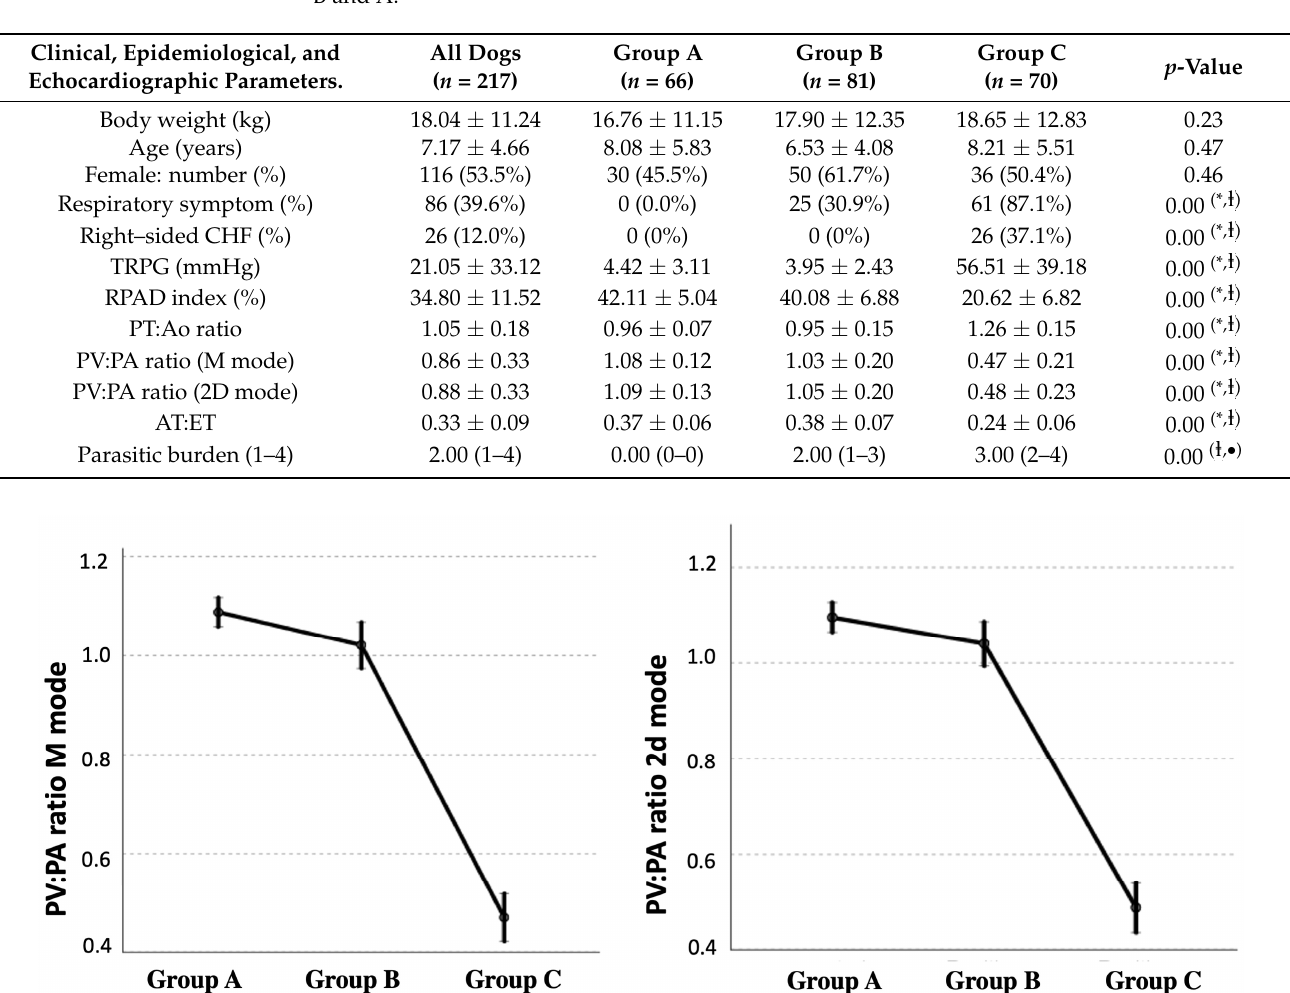
Figure 3. Linear regression illustrating right pulmonary vein to pulmonary artery (PV:PA) ratios in motion mode over time (M mode) and two-dimensional mode (2D mode). The M and 2D modes of the PV:PA ratios were highly positively correlated (r = 0.928). The correlation was significant at the 0.01 level (bilateral).